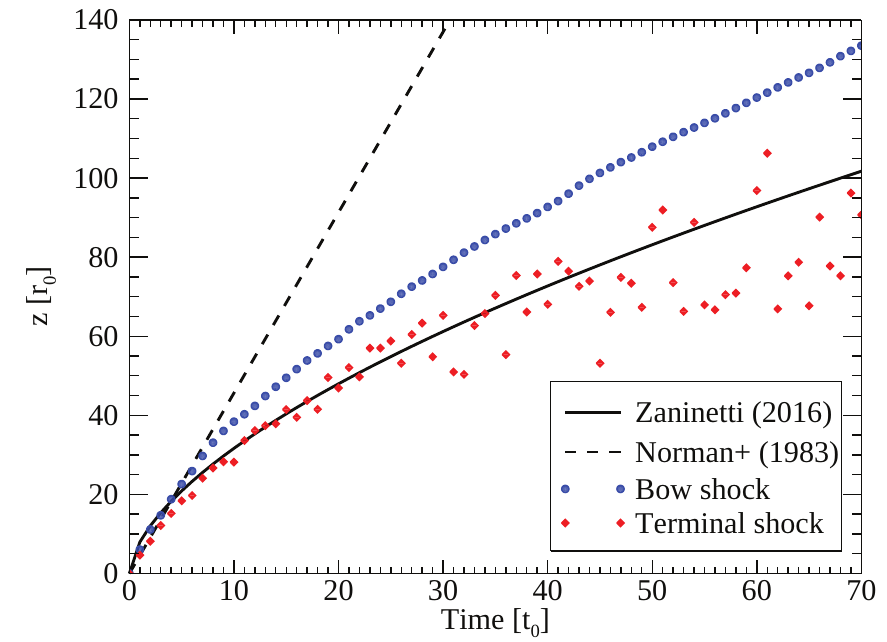
Figure 2. Time evolution of the bowshock and the terminal shock positions along the z -axis for model TWC. Analytic lines by Norman, Winkler and Smarr (dashed) and Zaninetti (solid) are also